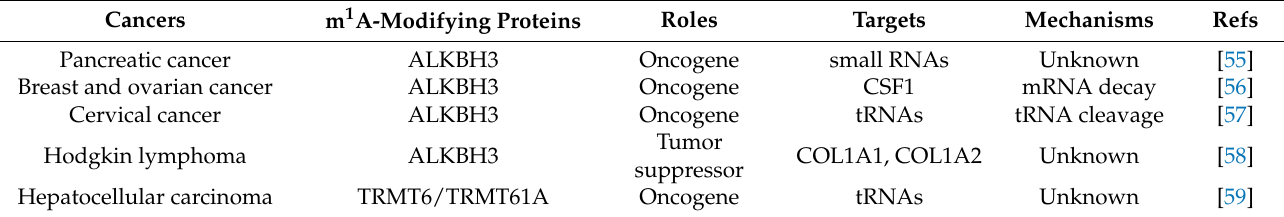
Table 1. Dysregulation of m 1 A RNA modification in human cancers.